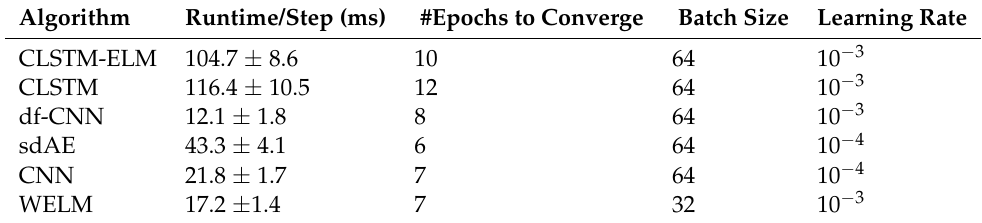
Table 4. Runtime comparison of the deep learning classifiers.